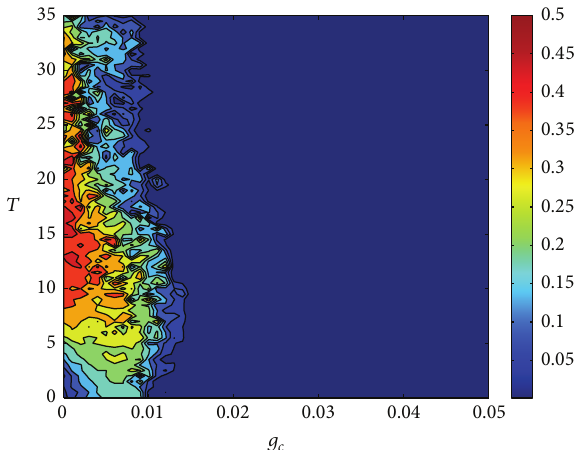
Figure 8: The contour plot of the average ISI distance in the (𝑔 𝑐 ,𝑇) plane for grid